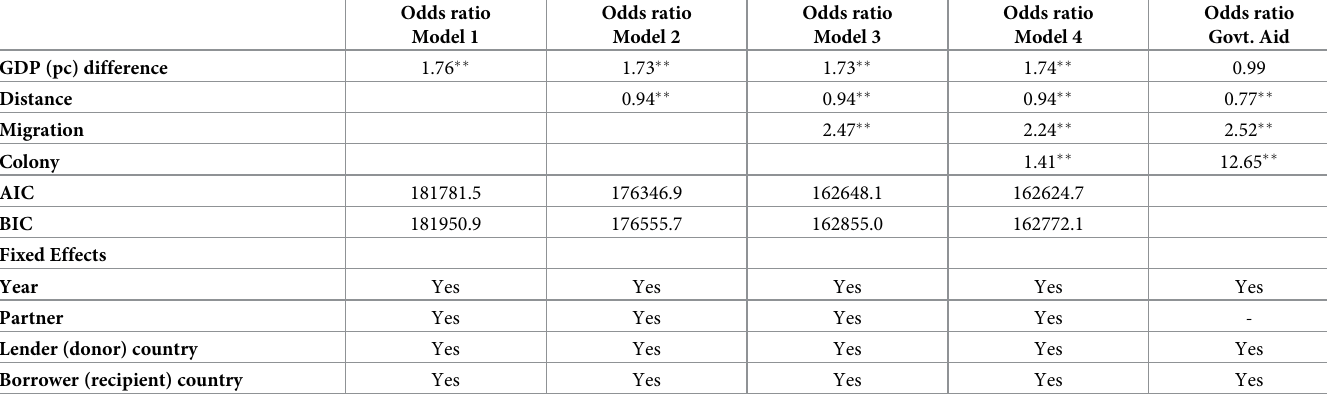
Table 1. Fixed-effect ologit estimates of levels of lending between countries. Odds ratio reported for 4 levels of transactions (4 levels of commitment amount in the case of government aid) as defined in the text and S1